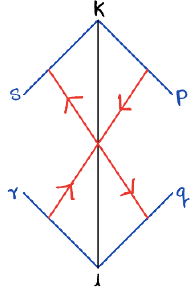
Figure 6 . Arrows and vertices near the diagonal ( k; l